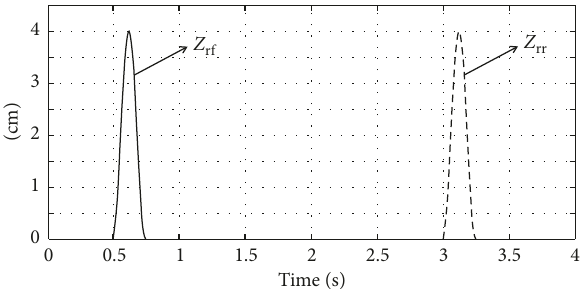
Figure 8: Road bump disturbance.